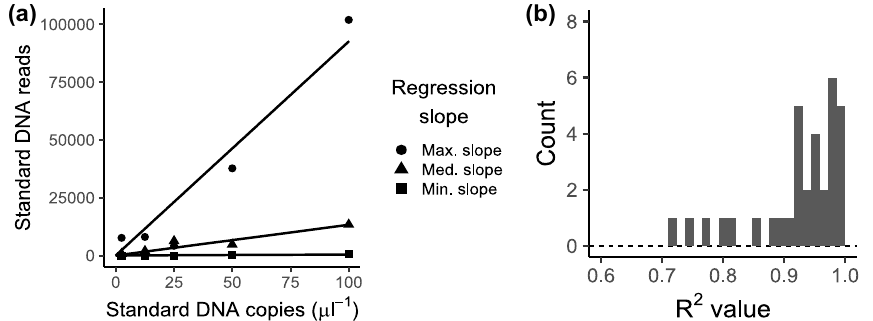
Figure 2. The relationships between sequence reads and the copy numbers of standard DNAs according to Ushio et al. 7 . ( a ) The relationships between sequence reads and the copy numbers of standard DNAs with the maximum, median, and minimum slopes. ( b ) Distribution of R 2 values of the regression